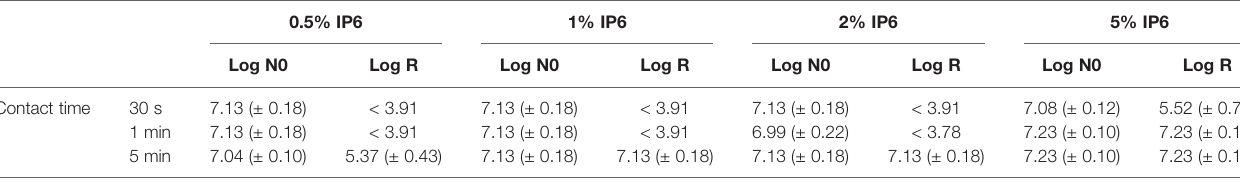
TABLE 3 | Log reduction of E. faecalis ATCC 29212 compared to the untreated control (log N0) using IP6 for 30 s, 1 min or 5 min.